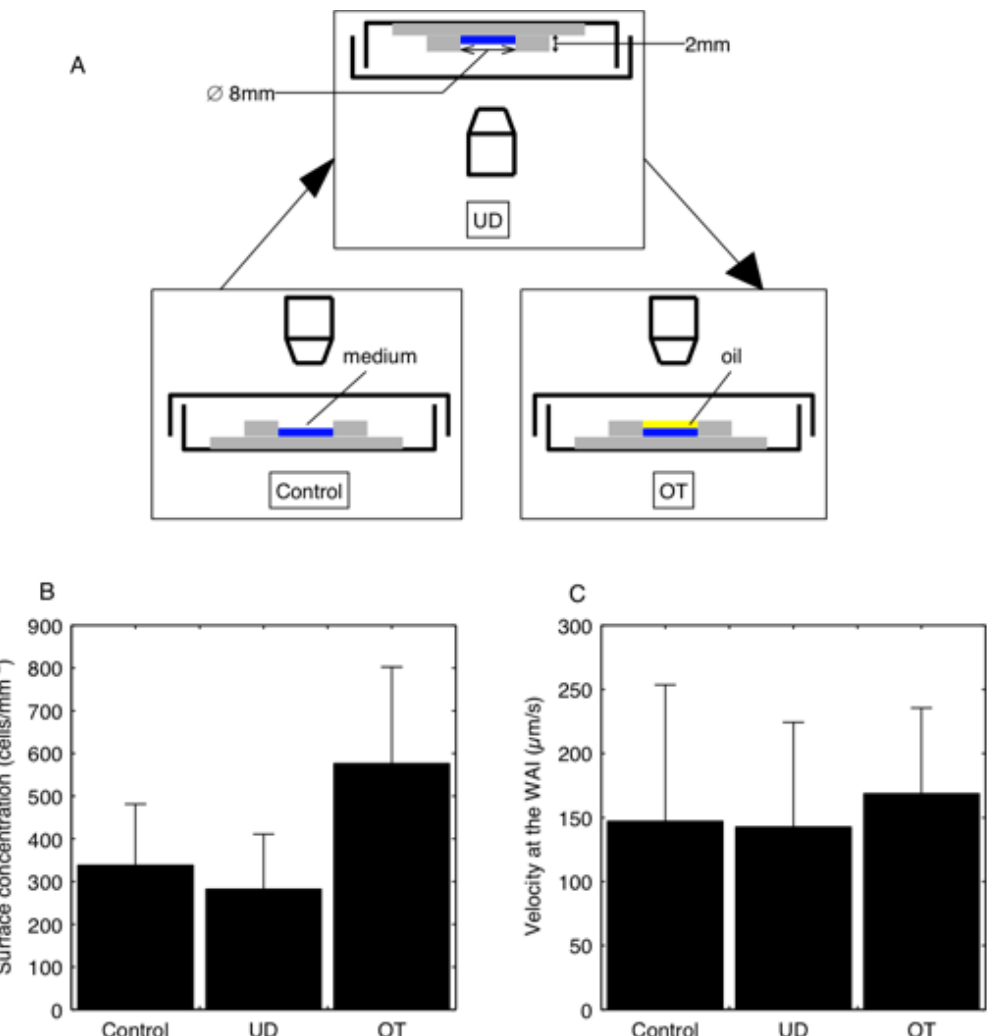
Figure 3. Behavior of cells under three different physiological conditions at day 5 (for six different samples): (A) set-up, (B) surface concentration, and (C) swimming velocity.